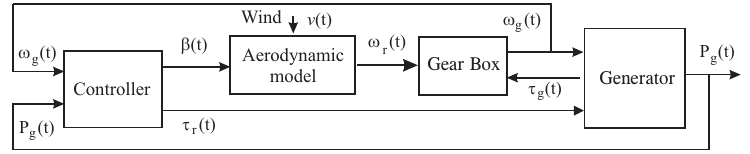
Figure 1. Scheme of the wind turbine